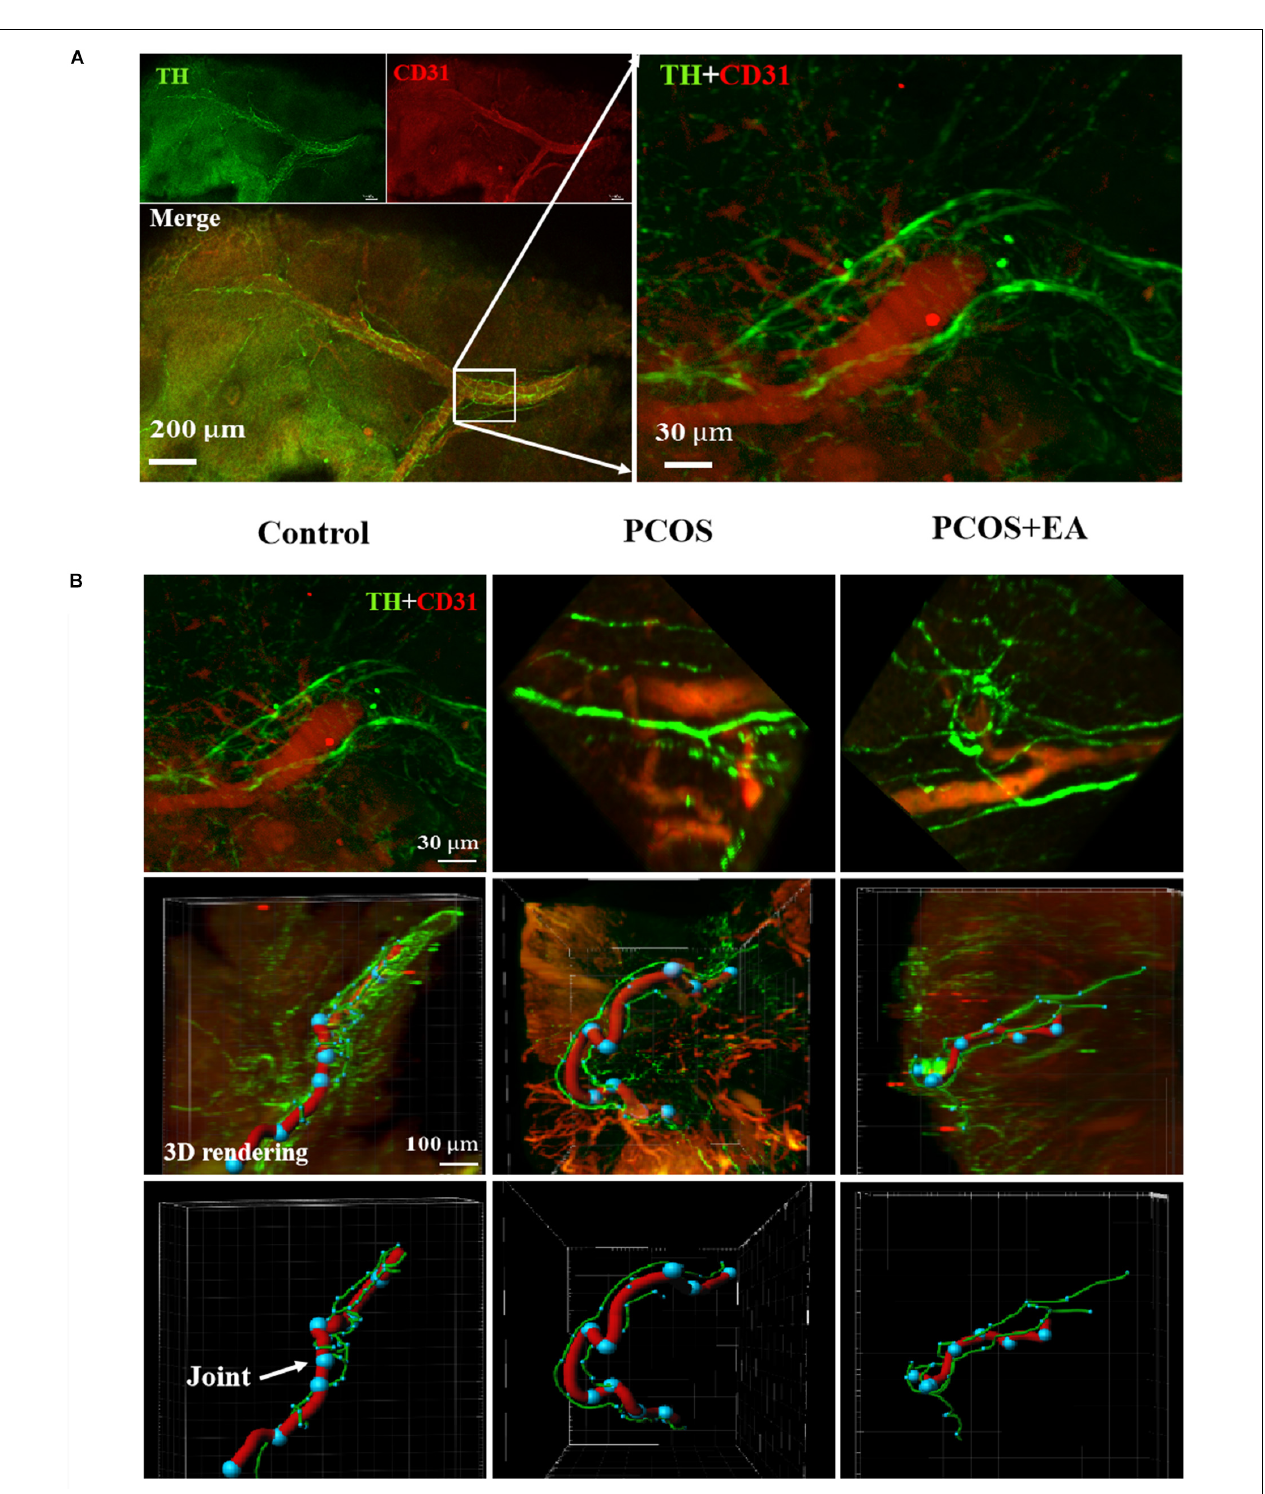
FIGURE 5 | Less joints of innervation of the vasculature near the hilum and follicles in PCOS ovaries, and this is reversed following EA. Ovaries from the three groups were obtained for innervation and blood vessel staining using TH and CD31, respectively. (A) The neurovasculature near the hilum of the ovary was visualized with antibodies against CD31 (red) or TH (green). (B) The upper panels show the different neurovascular alignments with the hilum in the Control, PCOS, and PCOA + EA groups. The major blood vessel passing through the hilum was identified using the Imaris software (the middle panels), and the joints between vessels and nerve fibers were marked as blue dots indicated by arrow (the bottom